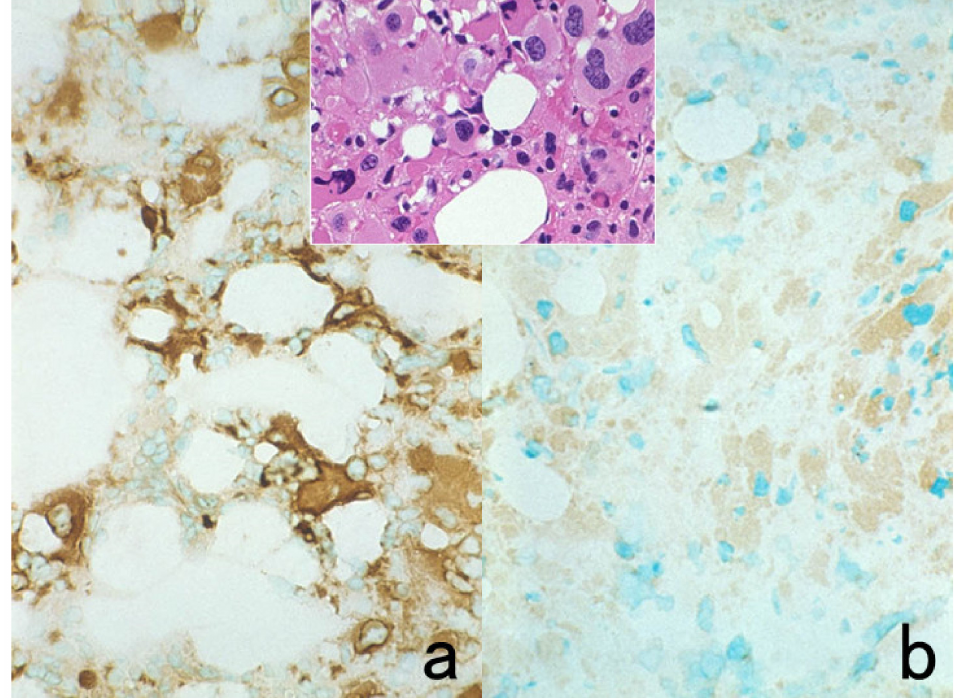
Figure 18. Antigenic loss of surface markers by endogenous peroxidase blockage in fresh-frozen sections. Aspirated bone marrow clot of essential thrombocythemia. Immunostaining for glycopro- tein IIb/IIIa (CD41/CD61), a megakaryocytic marker. ( a ): Without endogenous peroxidase blockage and ( b ): with endogenous peroxidase blockage, inset: H&E. Endogenous peroxidase blockage in 0.3% hydrogen peroxide in methanol significantly hampers the immunoreactivity. The nuclei are counterstained with methyl